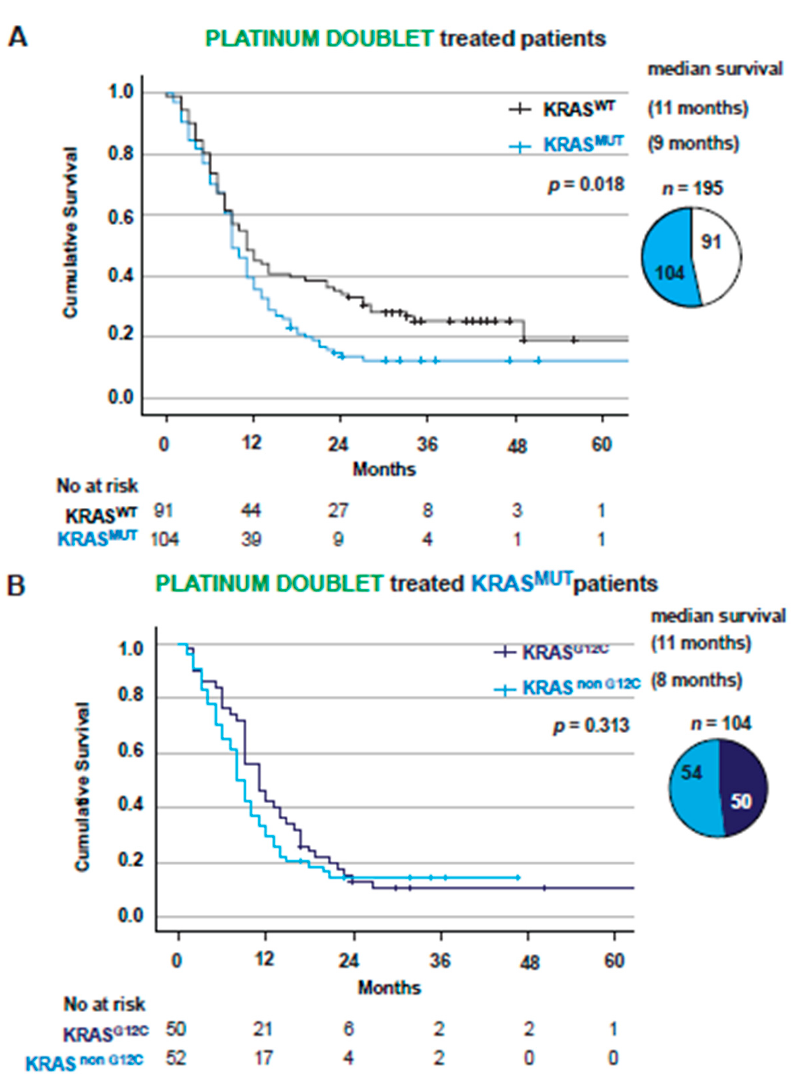
Figure 2. KRAS MUT is a negative factor for overall survival when treated with platinum doublet independently of EGFR and ALK mutations. ( A ) Kaplan–Meier estimates comparing overall survival for all receiving treatment with platinum doublet stratified on KRAS WT vs. KRAS MUT . Patients with EGFR and ALK alterations were excluded from KRAS WT group. Pie chart showing patient distribution between KRAS WT and KRAS MUT . ( B ) Kaplan–Meier estimates comparing overall survival for all KRAS MUT receiving treatment with platinum doublet stratified on KRAS G12C vs. KRAS non G12C . Pie chart showing patient distribution between KRAS G12C and KRAS non G12C .